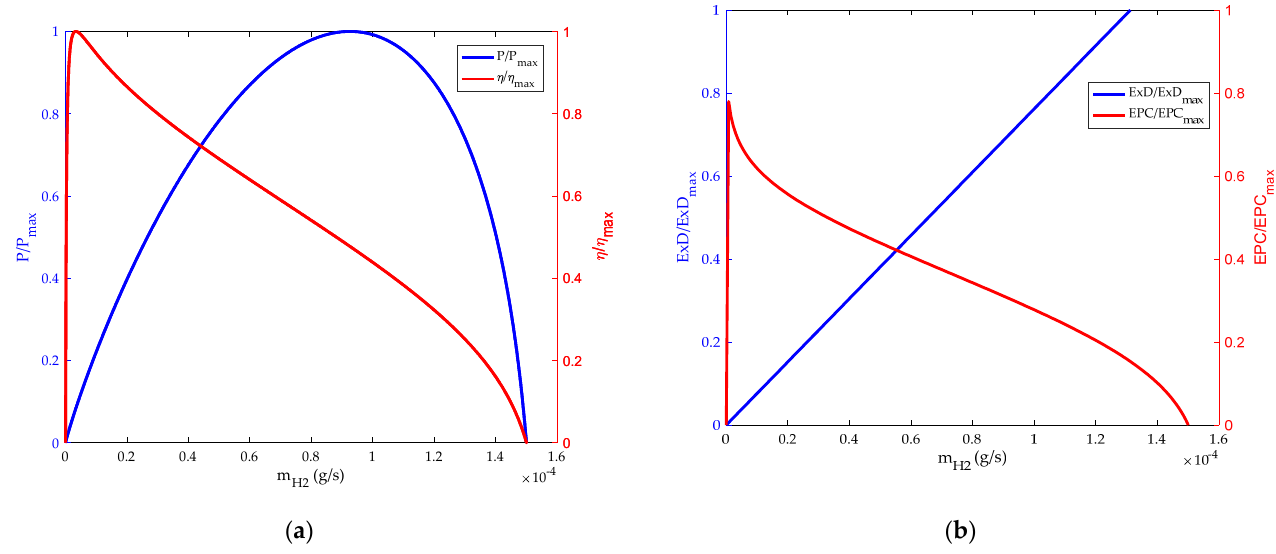
Figure 4. Influence of hydrogen flow rate. ( a ) Power density and energy efficiency; ( b ) exergy destruction rate and exergetic performance coefficient.